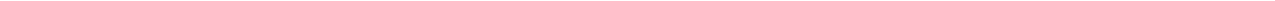
Fig. 4 Sfpq promotes miRNA targeting at selected binding sites. a Venn diagram of Ago2 or Sfpq RNA-IP-enriched miRNAs found by small RNA sequencing analysis. b Let-7a expression levels (upper panel) and RNA-IP of Ago2 and let-7a (lower panel) in control or siSfpq-transfected RAW 264.7 cells. RNA extracts were analyzed by RT-qPCR. Data are presented as the mean ± s.e.m. ( n = 6) and normalized to U2 snRNA or the input, respectively. c Sfpq, Pspc1, and NonO interact with mature let-7a in RA-treated P19 cells. Cell extracts were immunoprecipitated with the indicated antibodies and RNA was puri fi ed and analyzed by Northern blotting. Genomic distribution of either the d Ago2-let-7a or e endogenous Ago2-miRNA peaks decreased upon Sfpq knockdown, according to the distance to Sfpq peaks by HITS-CLIP analysis. These data show the prevalence of the Sfpq-dependent Ago2 peaks in the 3 ′ UTR when Sfpq binds closely ( < 500 nt). RNA-IP of Ago2 and the indicated 3 ′ UTRs for either f let-7a or g the endogenously expressed miR-302b-binding sites. P19 cells were transfected with the indicated molecules. Nucleoplasm and cytoplasm fractions were separated. The indicated cell lysates were incubated with either 100 nM full-length recombinant wild-type Sfpq or the Sfpq-214 – 598 quadruple mutant (L535A, L539A, L546A, and M549A) for 30 min at room temperature. Before IP, the lysate was partially digested with 10 μ g ml − 1 RNase A for 30 min at room temperature. RNA was puri fi ed from the immunocomplexes and from 5% of the input and analyzed by RT-qPCR using oligonucleotide probes surrounding the miRNA-binding sites identi fi ed by HITS-CLIP. Data are presented as the mean ± s.e.m. ( n = 3) and normalized to their own inputs. Student ’ s t -test (for b ) or one-way ANOVA followed by Tukey ’ s post hoc test (for f , g ) with * p < 0.05 and ** p < 0.01. ns not signi fi cant, TTS transcription termination